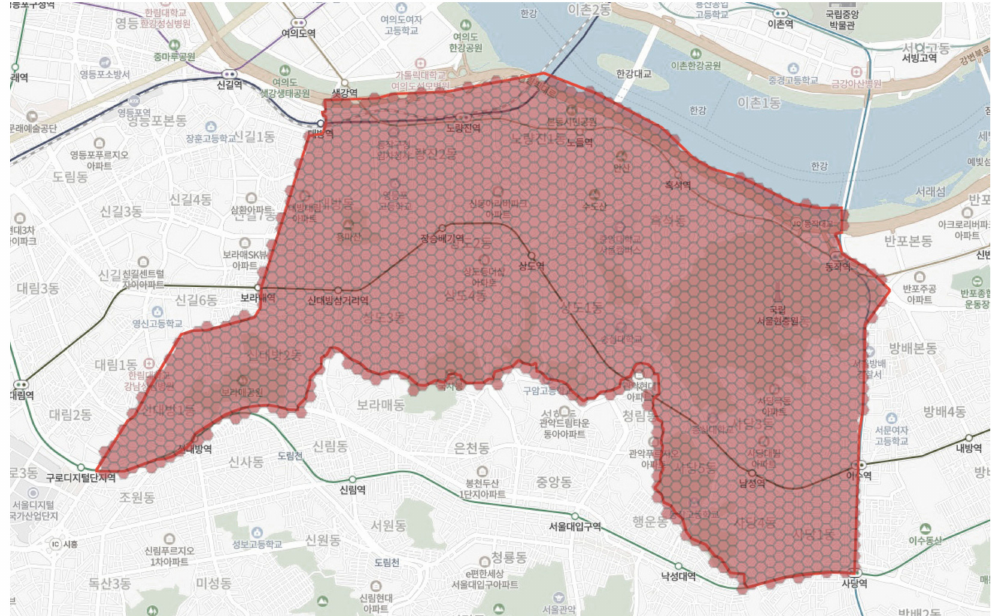
Figure 3. A map of Dongjak District, Seoul in a hexagon grid with a 50 m